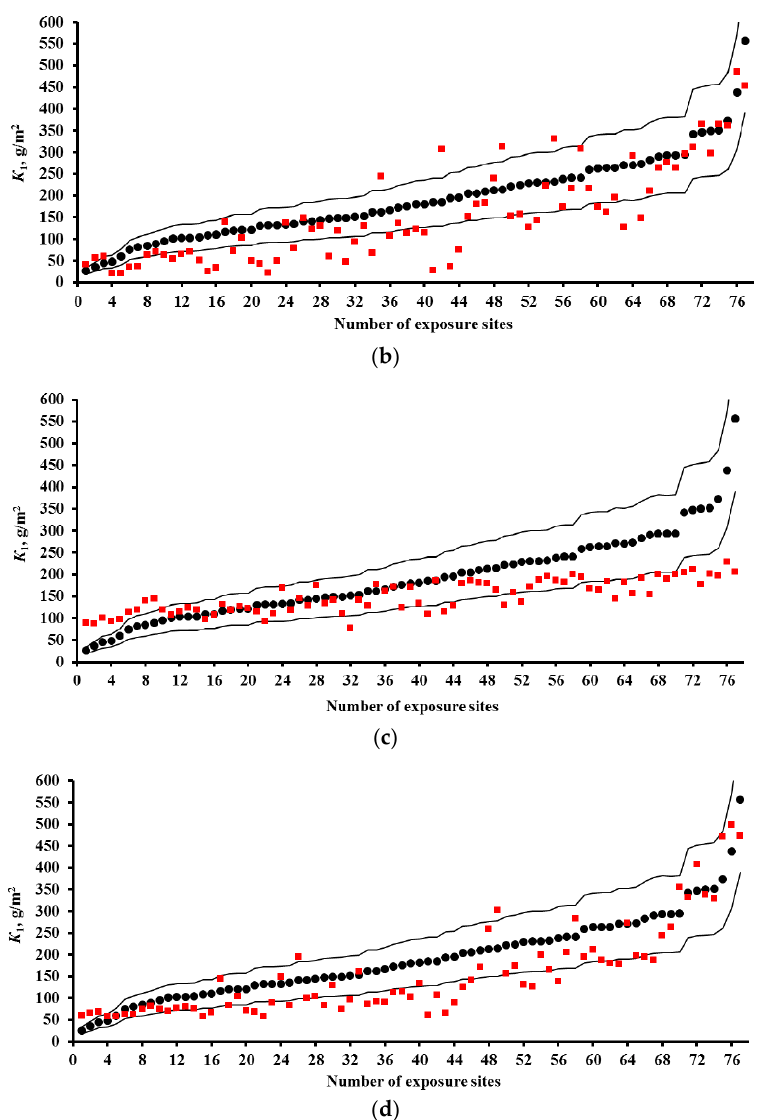
Figure 3. Carbon steel. UN/ECE program. K 1 predictions by the New DRF ( a ); Standard DRF ( b ); Unified DRF ( c ); and Linear DRF [20] ( d ). ● —experimental K 1 data; ■ — K 1 predictions. Thin lines show